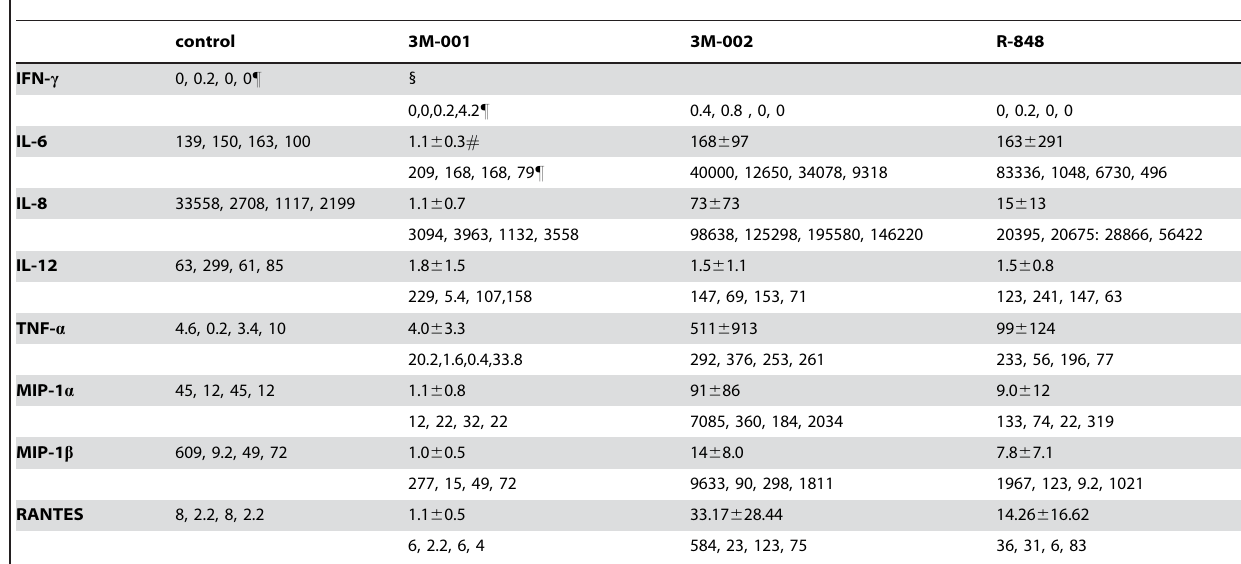
Table 3. Induction of cytokines (pg/ml) two days after triggering TLR7 and/or 8 in MoMDC; indicated are the average 6 std fold induction # and the individual absolute concentrations of cytokines measured in the supernatant [pg/ml] "